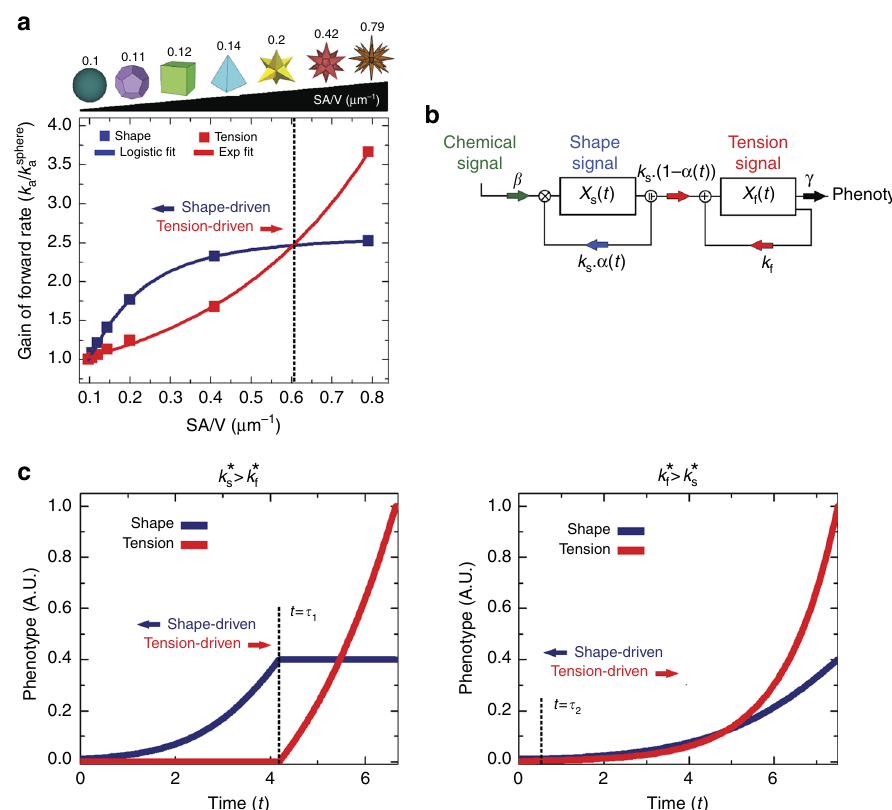
Fig. 2 Multiple types of signals can regulate cellular phenotype. a Tension- (red) and shape (blue)-dependent association rate constants ( K a ) as functions of SA/V ratio based on a series of 3-D geometries. As the SA/V gets higher, shape signals are dominant until around SA/V ≅ 0.6 when the system becomes tension-driven. The term K a = K sphere represents the relative change with respect to a spherical reference. b Control state diagram for shape and a tension-driven phenotypes. The state variables X s ( t ) and X f ( t ) represent phenotypic contributions of the shape and tension signals, respectively. k s and k f represent the rates by which shape and tension signals alter the phenotype, respectively. γ is the natural decay (degradation) rate of the phenotype. β represents the probability of chemical induction via other extracellular ligands. α ( t ) is the control function that represents the probability of the cell to react to shape signals, and [1 − α ( t )] is the probability to react to tension signals. c Phenotypic state as a function of time depicting optimal solution for the > k (cid:1) dynamics of shape- (blue) and tension- (red) driven phenotypes. When k (cid:1) , shape cues are dominant in driving phenotype, whereas tension becomes s f < k (cid:1) the main driver when k (cid:1) s